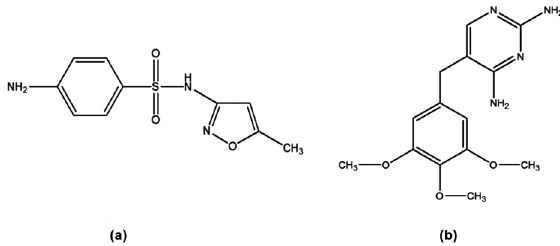
Figure 1 - Sulphamethoxazole (A) and trimethoprim (B) structural